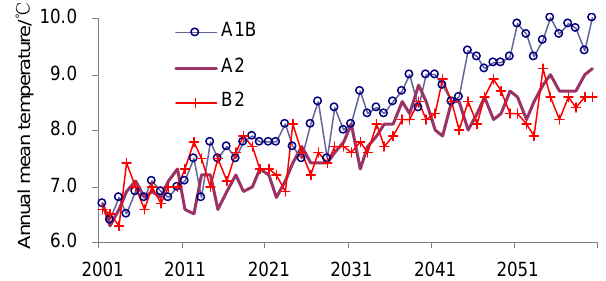
Fig. 6. Projected annual mean air temperature over China under emissions scenarios A1B, A2 and B2.